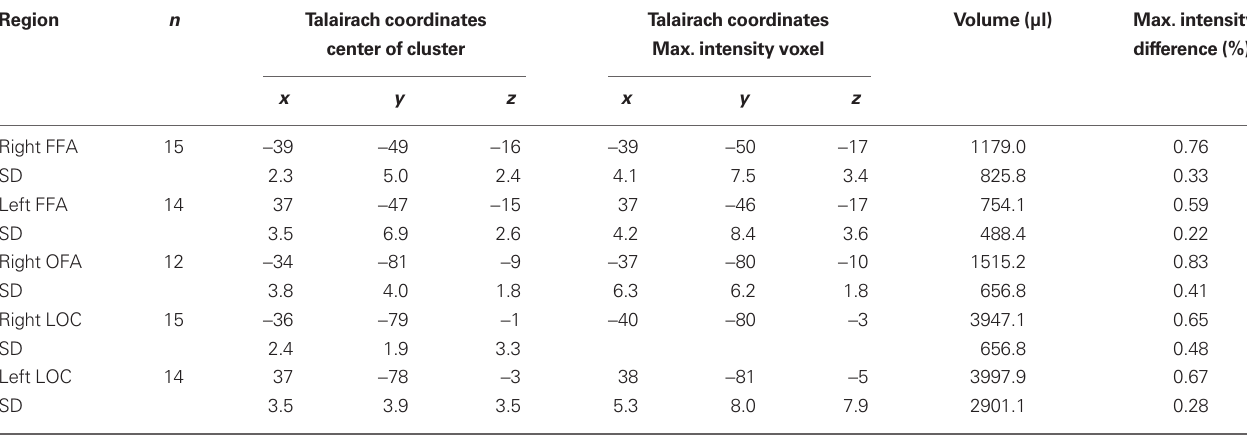
Table 1 | Characterization of FFA, OFA, and LOC regions of interest.